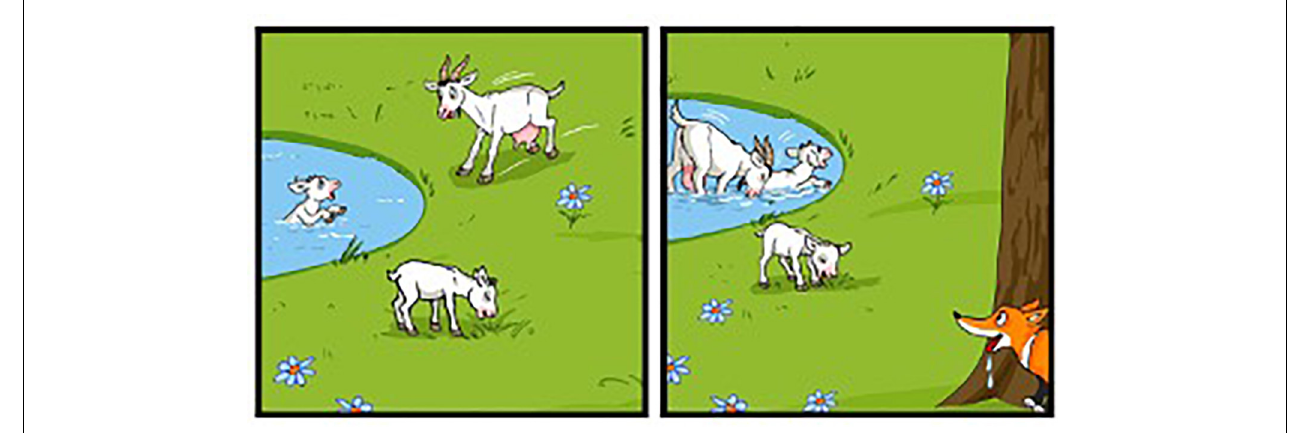
FIGURE 1 | Episode 1 of the Baby goats in the MAIN story telling (from Gagarina et al.,